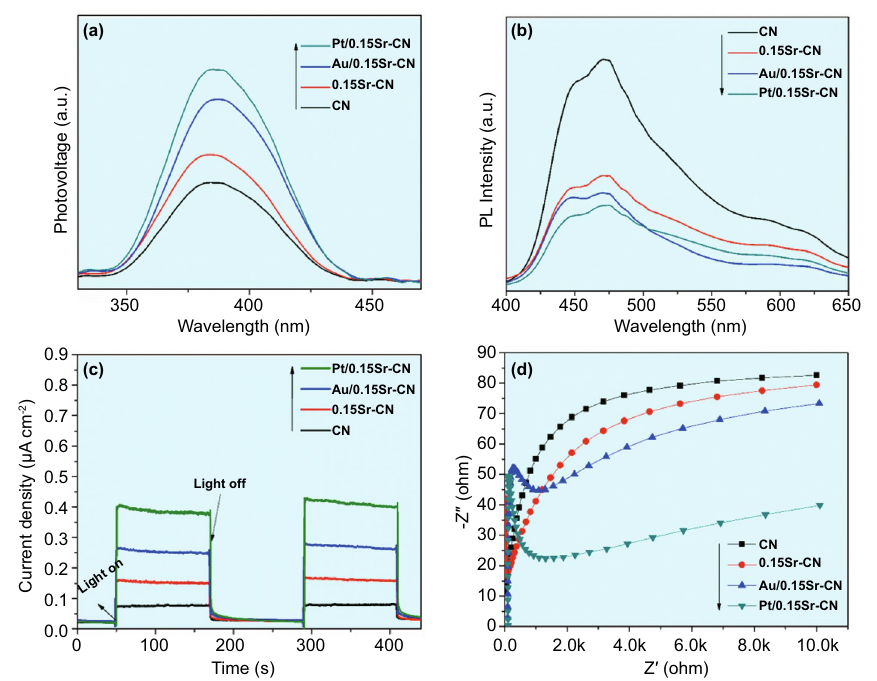
Fig. 8 a Surface photovoltage responses, b photoluminescence responses, c photo-electrochemical I-t curves, and d electrochemical impedance spectra of CN, 0.15Sr-CN, Au/0.15Sr-CN, and